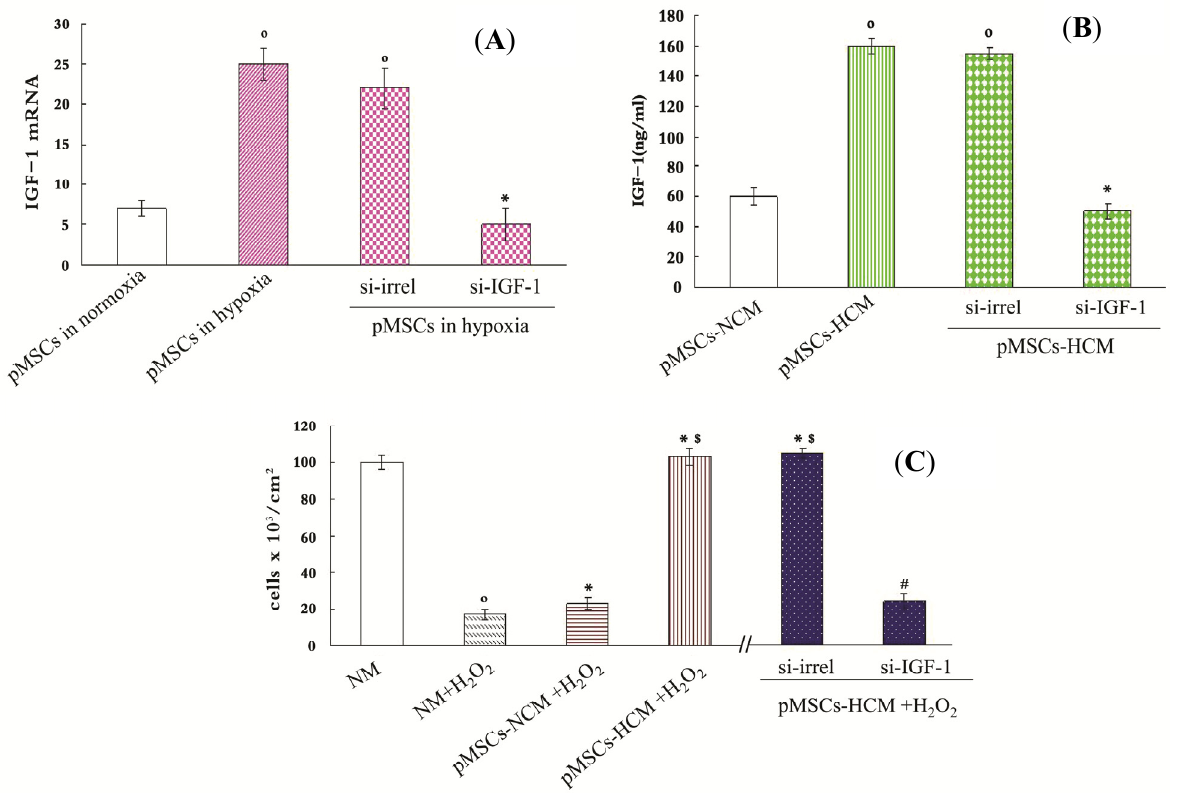
Figure 4. The pMSCs hypoxia culture medium is more conducive to promote H O -treated-caco2 cells proliferation via IGF-1. ( A and B ) Silence IGF-1 in pMSCs by 2 2 siRNA: ( A ) After two-day culture, pMSCs in hypoxia had much more IGF-1 mRNA than that in normoxia, and it is the same with pMSCs in hypoxia transfected with si-irrel. When cultured in hypoxia, si-IGF-1-pMSCs had much less IGF-1 mRNA than si-irrel-pMSCs. º p < 0.05 versus pMSCs in normoxia; * p < 0.05 versus si-irrel-pMSCs in hypoxia ( n = 6); ( B ) IGF-1 protein level in pMSCs-HCM and siirrel-pMSCs-HCM were much higher than that in pMSCs-NCM after four-day culture. IGF1 protein level in si-IGF-1-pMSCs-HCM obviously decreased compared with si-irrelpMSCs-HCM; º p < 0.05 versus pMSCs-NCM; * p < 0.05 versus si-irrel-pMSCs-HCM ( n = 6); ( C ) Trypan blue staining is used to detect O -treated-caco2 cells were cultured in NM, pMSCs-NCM, viable cell number. After H 2 2 pMSCs-HCM, si-irrel-pMSCs-HCM or si-IGF-1pMSCs-HCM for five days, viable cell number were assessed. º p < 0.05 versus NM; * p < 0.05 versus NM + H O ; # p < 0.05 versus si-irrel-pMSCs-HCM + H versus pMSCs-NCM + H 2 2 and ( D ) MTT is used to detect cellular metabolic activity. After H cells were cultured in NM, pMSCs-NCM, pMSCs-HCM, si-irrel-pMSCs-HCM or si-IGF-1pMSCs-HCM for five days, cellular metabolic activity were assessed by MTT. O ; $ p < 0.05 versus pMSCs-NCM + H * p < 0.05 versus NM + H 2 2 si-irrel-pMSCsHCM + H O ( n = 2 2